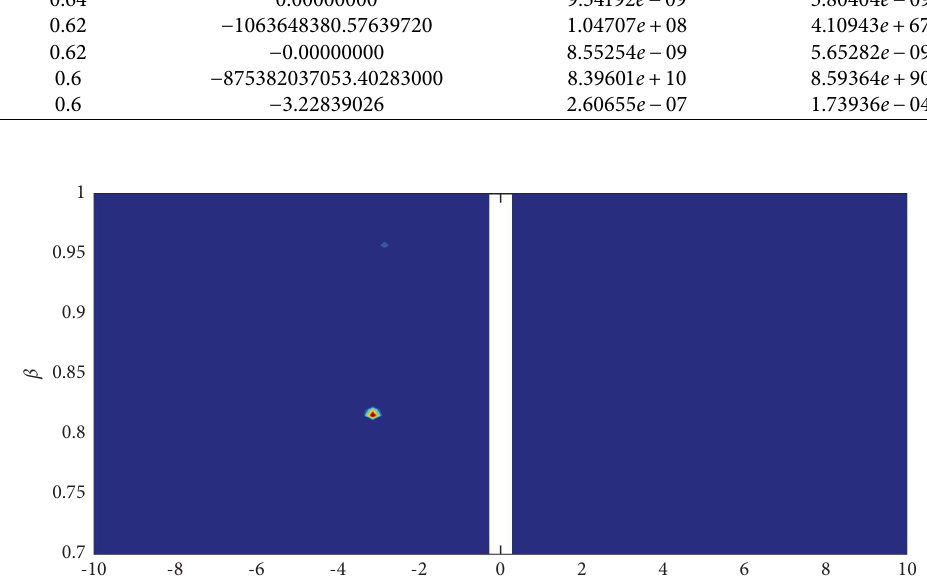
Figure 5: Convergence planes of frst-order NR on f